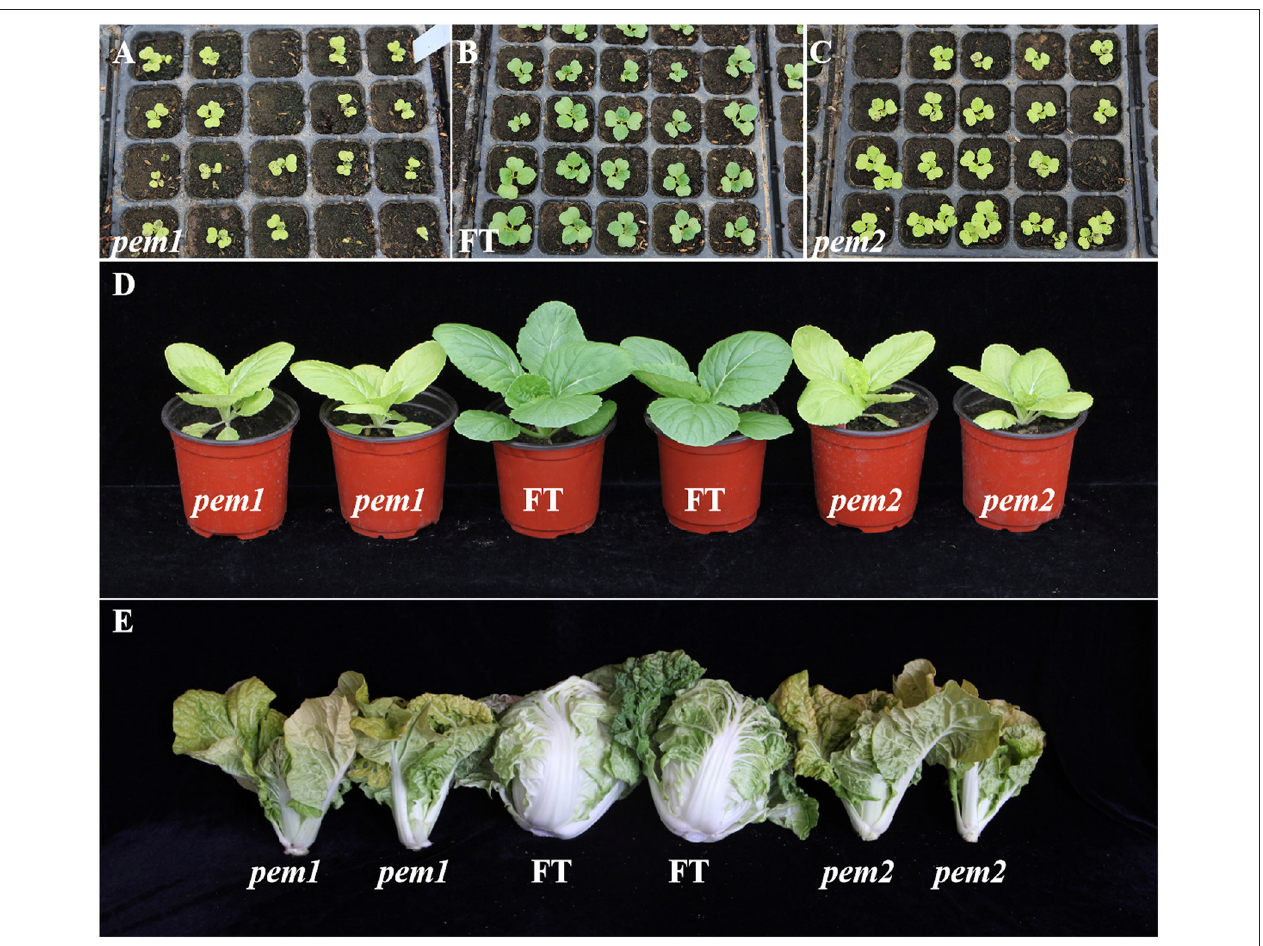
FIGURE 1 | Phenotypic characterization of pem1 , pem2 , and “FT.” (A-C) Phenotypic characterization of pem1 (B) and pem2 (C) compared with “FT” (A) at cotyledons stage. (D) Phenotypic characterization of pem1 and pem2 compared with “FT” at the seedling stage. (E) Phenotypic characterization of pem1 and pem2 compared with “FT” at the heading